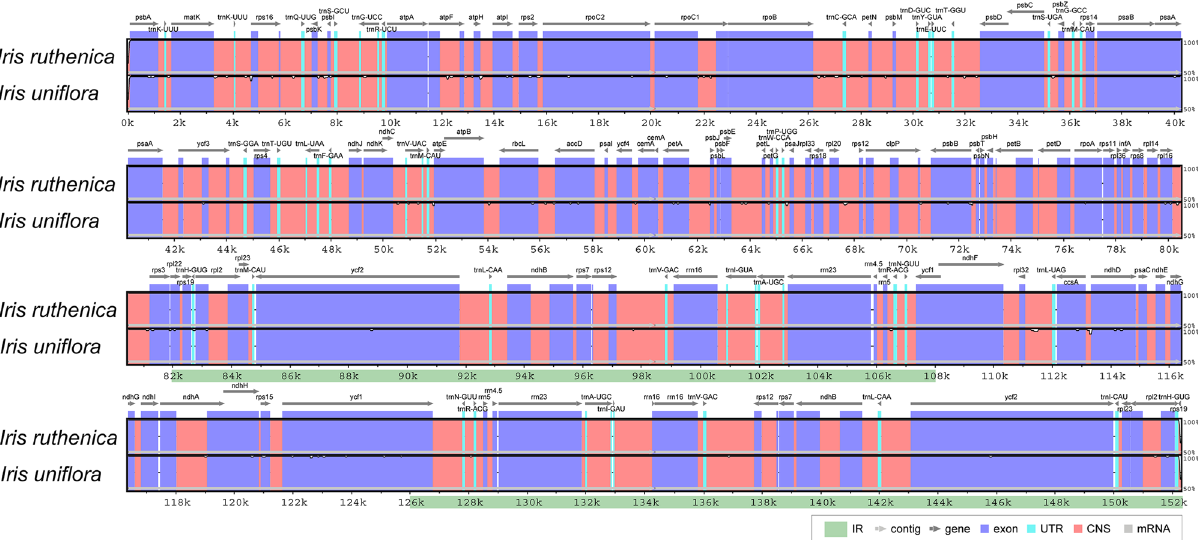
Figure 5. Comparison of Iris ruthenica and I. uniflora plastomes using mVISTA. Complete plastomes of I. ruthenica and I. uniflora were compared to that of I. ruthenica . Blue block: conserved genes; sky-blue block: transfer RNA (tRNA) and ribosomal RNA (rRNA) genes; red block: conserved non-coding sequences (CNS). Regions with sequence variation between I. ruthenica and I. uniflora are denoted in white. Horizontal axis indicates coordinates within plastomes. Vertical scale represents percent identity, ranging from 50–100%.